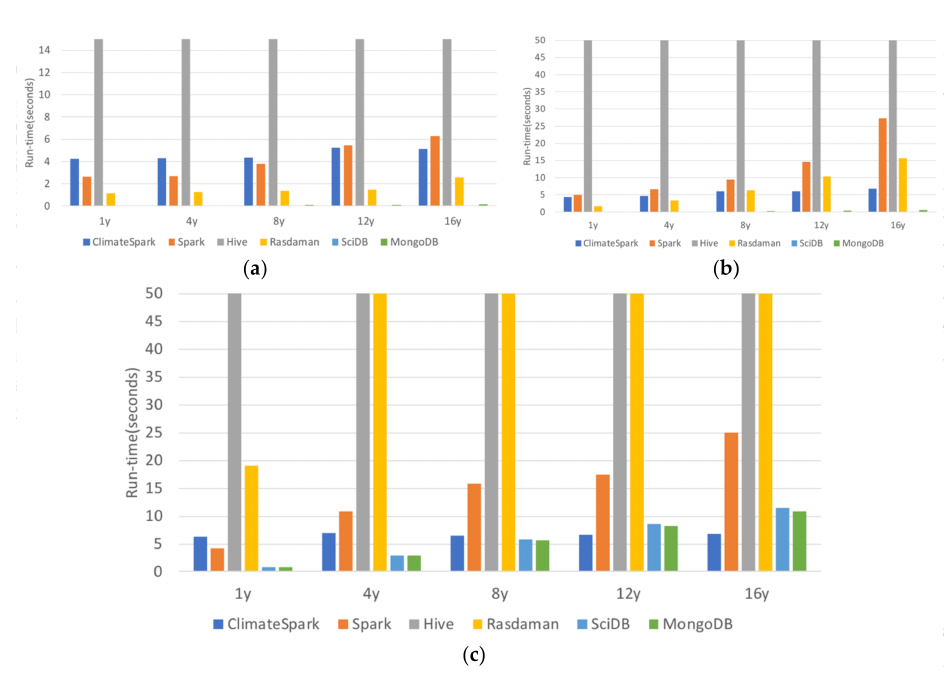
Figure 7. The spatiotemporal query for the 3D variable at : ( a ) the point (Boulder) time series query by varying the time range; ( b ) the area average for the Colorado State by varying the time range; and ( c ) the global average by varying the time